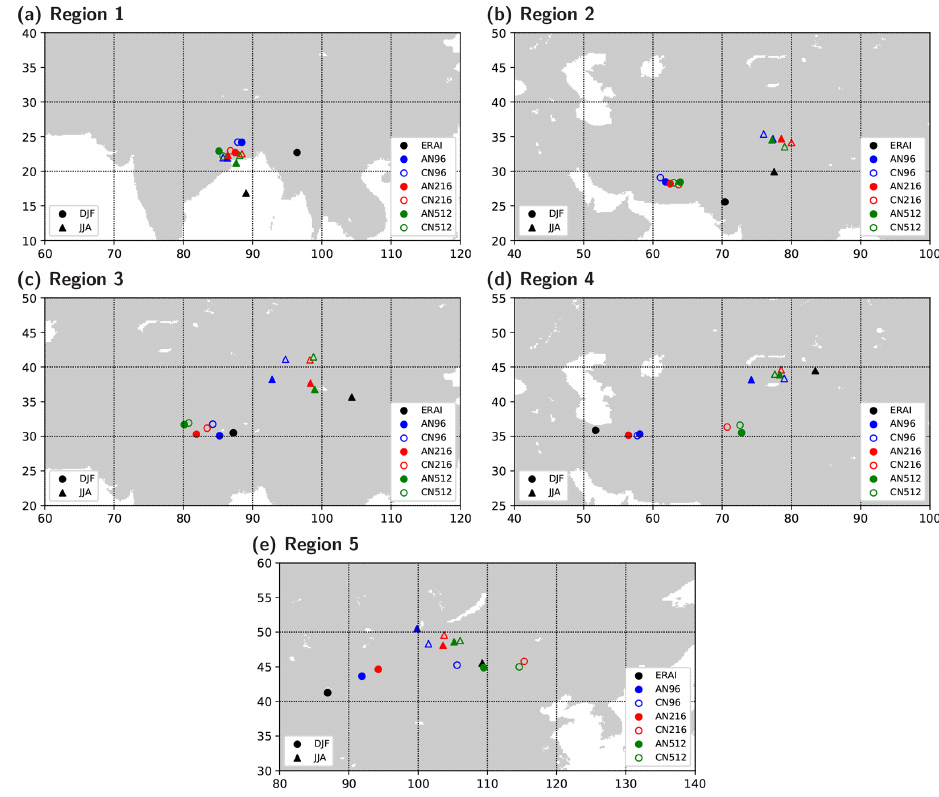
Figure 6. Mass centres of moisture source in DJF and JJA for regions 1–5 from ERA-Interim and MetUM